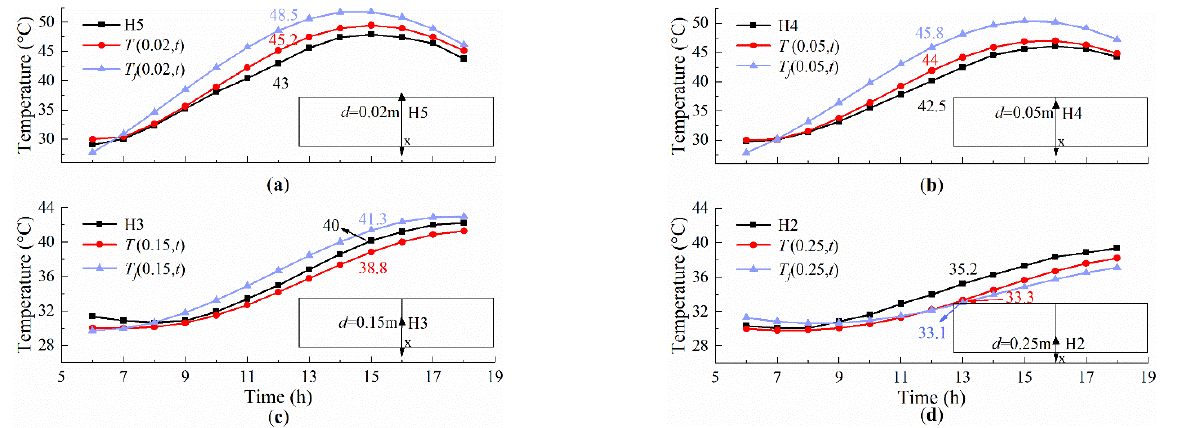
Figure 16. Results of the analytical, empirical, and measured temperatures on 23 July 2020. ( a ) H5; ( b ) H4; ( c ) H3; ( d ) H2.